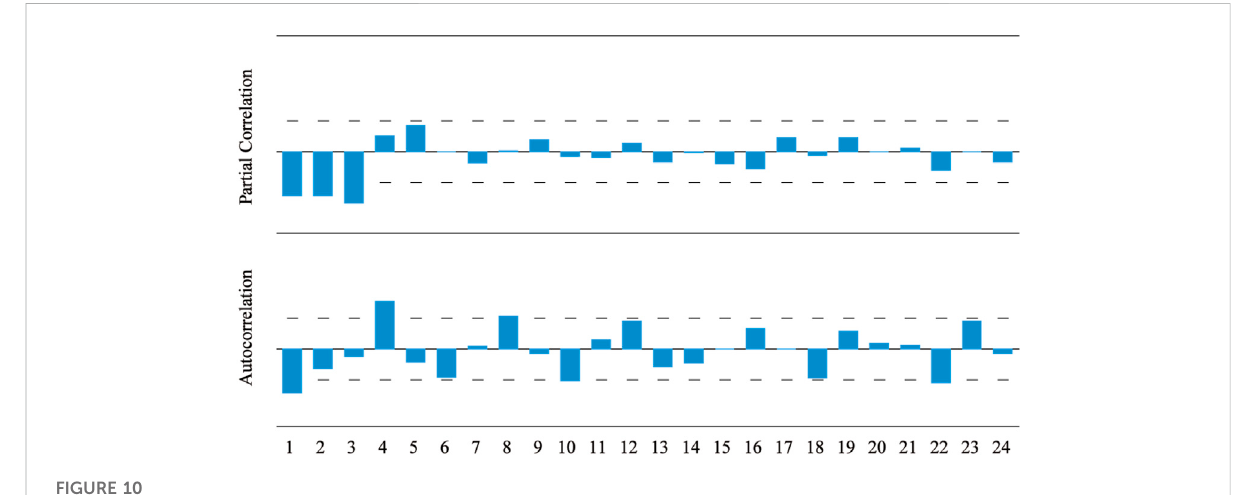
FIGURE 10 Stationarity test of the Second-order difference results.